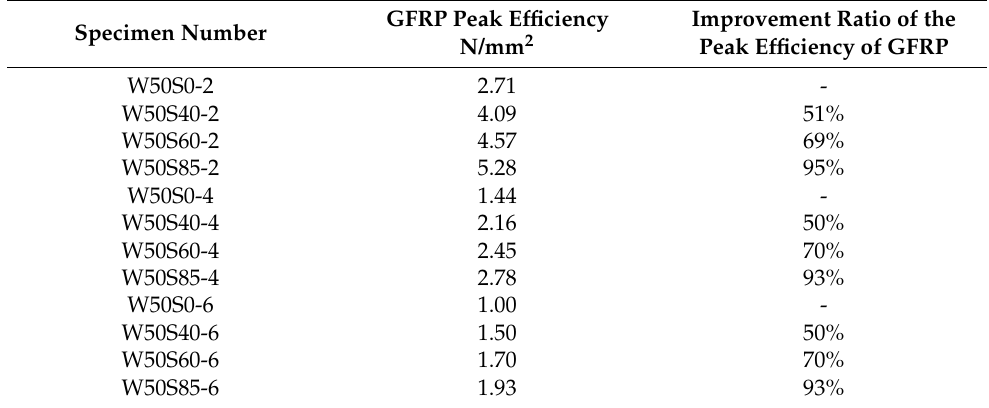
Table 10. Improvement ratio of the peak efficiency of GFRP